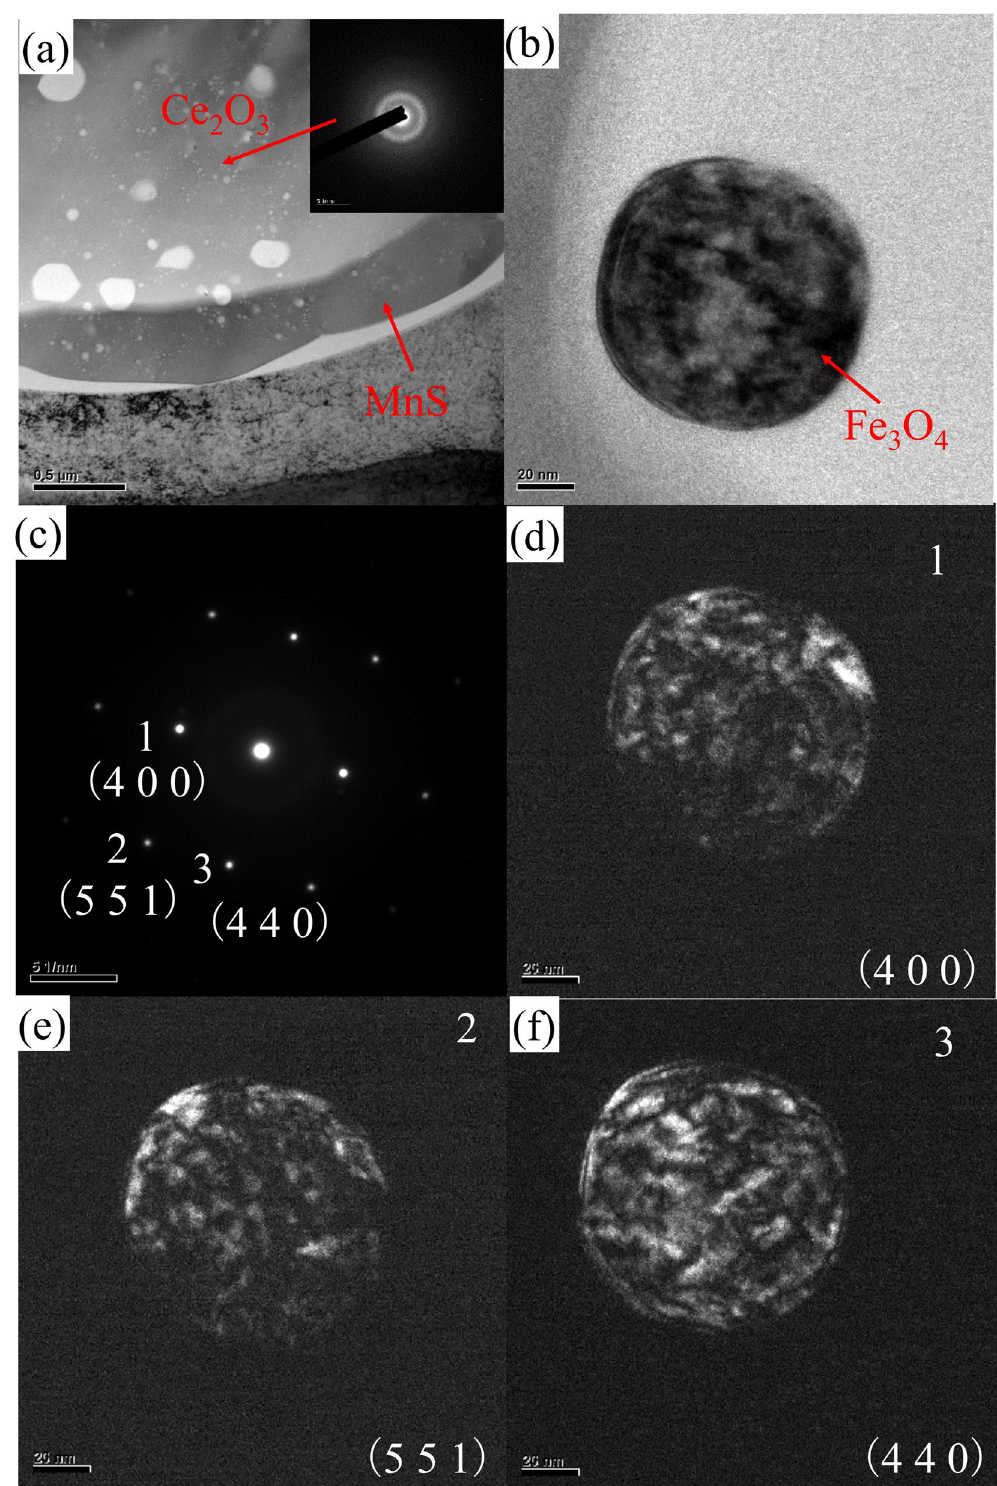
Figure 4. ( a ) TEM results of the complex inclusion found in sample DM-6, ( b ) morphology of nano Fe 3 O 4 found in sample DM-6 and ( c – f ) SAD results of nano Fe 3 O 4 found in sample